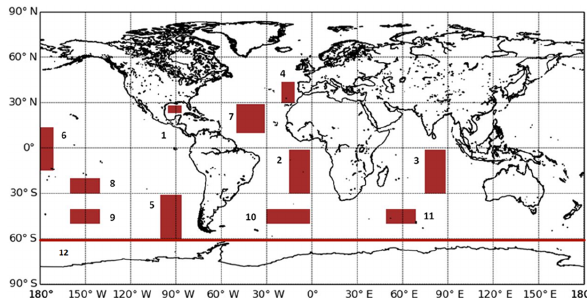
Figure 2. Selected regions to determine regional variations of W(U 10 )